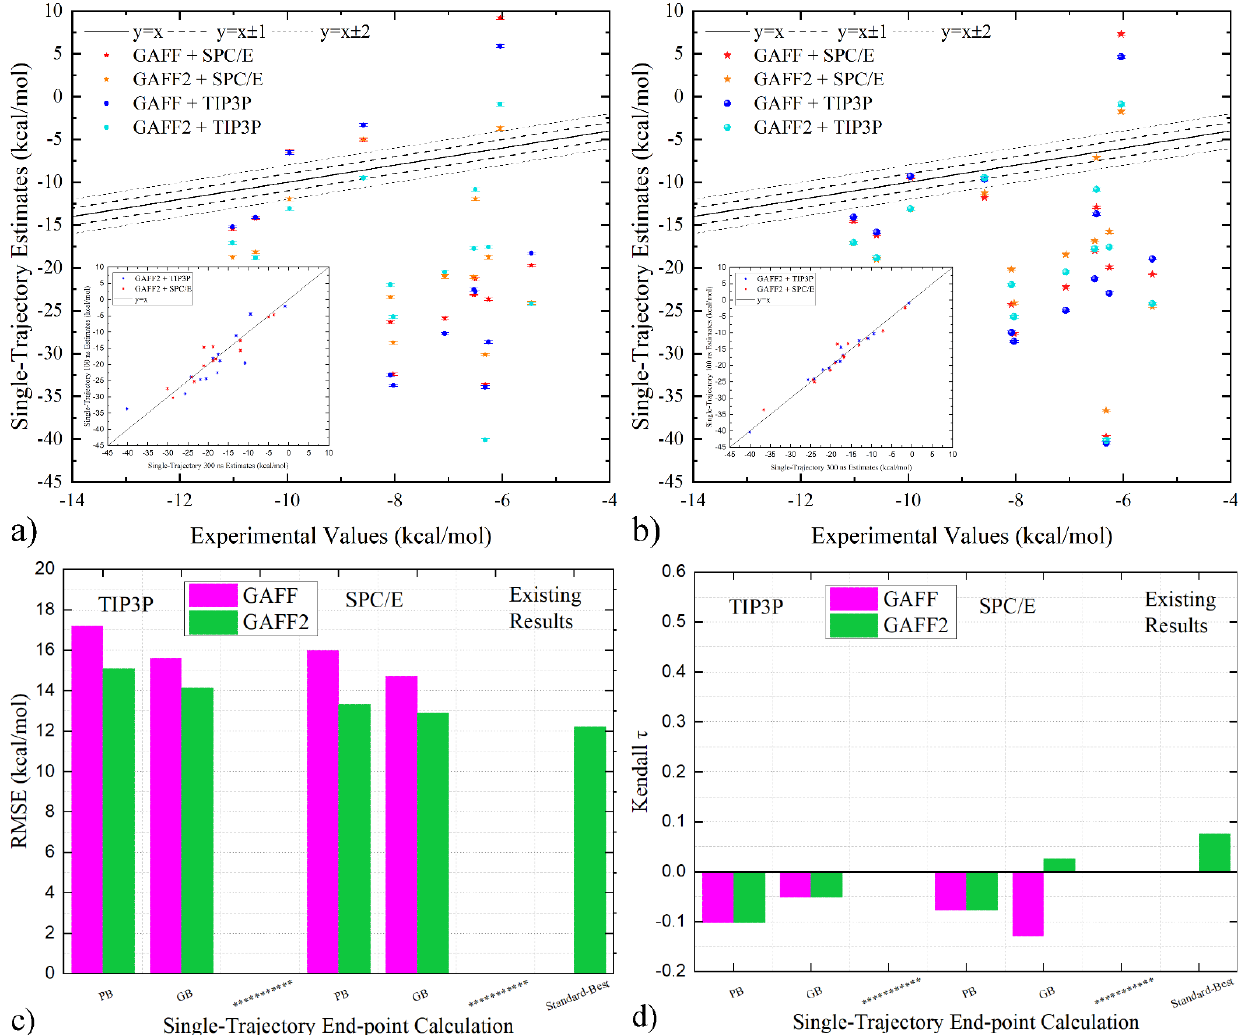
Figure 2. Correlation of single-trajectory end-point estimates and experimental reference under GAFF and GAFF2 with ( a ) PB and ( b ) GB implicit solvent treatment. The newly generated 300-ns trajectories are used in calculation, and the 100 ns GAFF2 results obtained from our previous work are compared in the inset of each subplot. ( c , d ) Comparison between quality metrics of single-trajectory end-point estimates under GAFF and GAFF2. It is clearly shown that in most cases the GAFF estimates are even less satisfactory than GAFF2. Therefore, all single-trajectory end-point estimates obtained from the straightforward calculation are not really useful in host–guest binding.